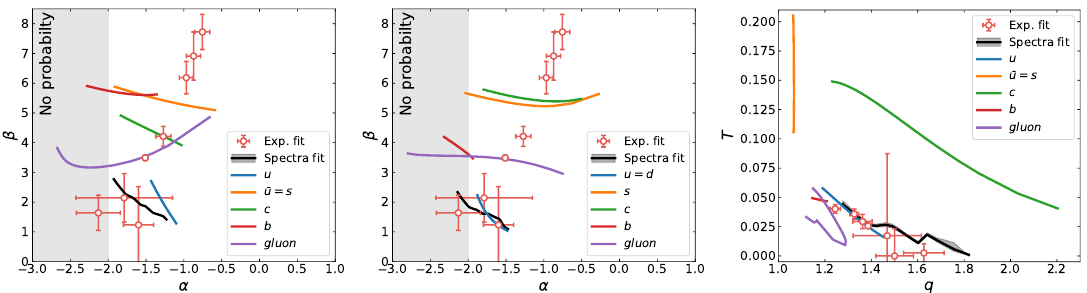
Figure 2. Parameters of the HKNS ( left ), KKP ( middle ) and microcanonical Tsallis FF ( right ) are plotted for different Q values and partonic channels. Gray area shows where the polynomial FFs loose the probability meaning. Experimental data and the scale evolved spectra was also fitted with a single distribution in respect to Equations (4) and (5), described in the